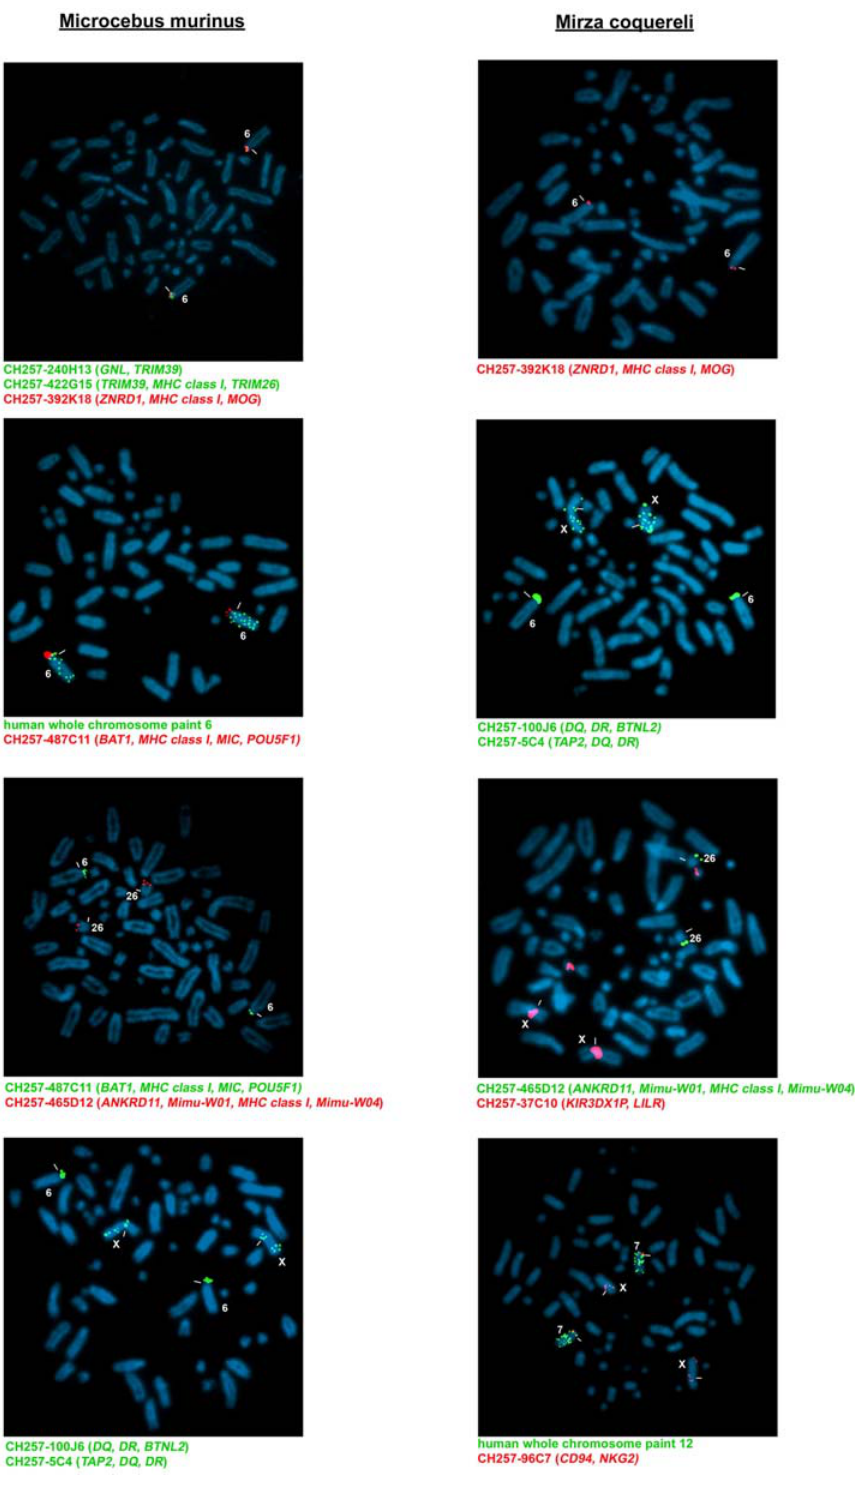
Figure 2. Chromosomal localisation of lemur MHC and NK cell receptor genes. FISH using mouse lemur BACs containing MHC class I and class II genes reveals a split of class I genes to chromosome 6 (GNL, TRIM39, TRIM26, ZNRD1, MOG, BAT1, MIC, POU5F1) and to chromosome 26 (ANKRD11, Mimu-W01, Mimu-W04) of Microcebus murinus. Nomenclature of M.murinus and M.coquereli chromosomes are according to Ref. [43] The same split is shown for Mirza coquereli: ZNRD1 and MOG hybridise to chromosome 6 and ANKRD11, Mimu-W01, and Mimu-W04 to chromosome 26. All tested MHC class II region genes (TAP2, DQ, DR, BTNL2) map to chromosome 6 in Microcebus murinus and Mirza coquereli, respectively. Note that in both species secondary signals appear scattered along the X chromosome. In Mirza coquereli, KIR-including BAC CD257-37C10 hybridises to a small acrocentric chromosome not identical with chromosome 26 and to the X chromosome, and NKG2-including BAC CH257-96C7 maps to chromosome 7, which is orthologous to human chromosome 12. Note that further signals appear on the chromosome X.